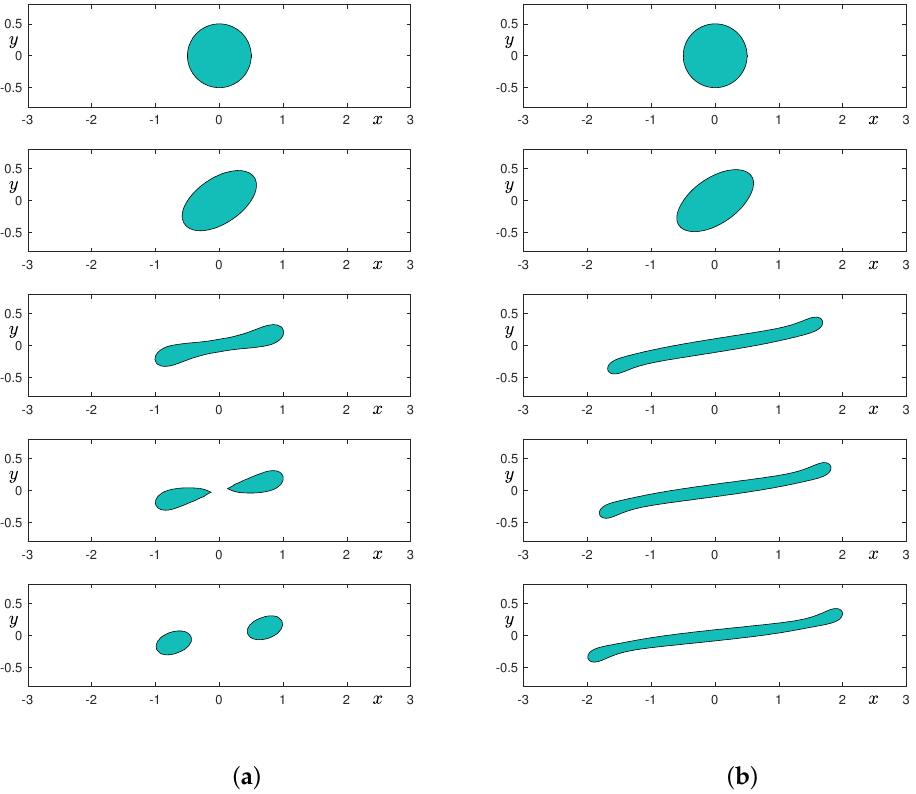
Figure 4. Temporal evolution of a droplet in shear flow: ( a ) 96 × 32 grid and ( b ) 192 × 64 grid. From top to bottom, times are at t = 0, 0.7, 5.25, 5.95, and